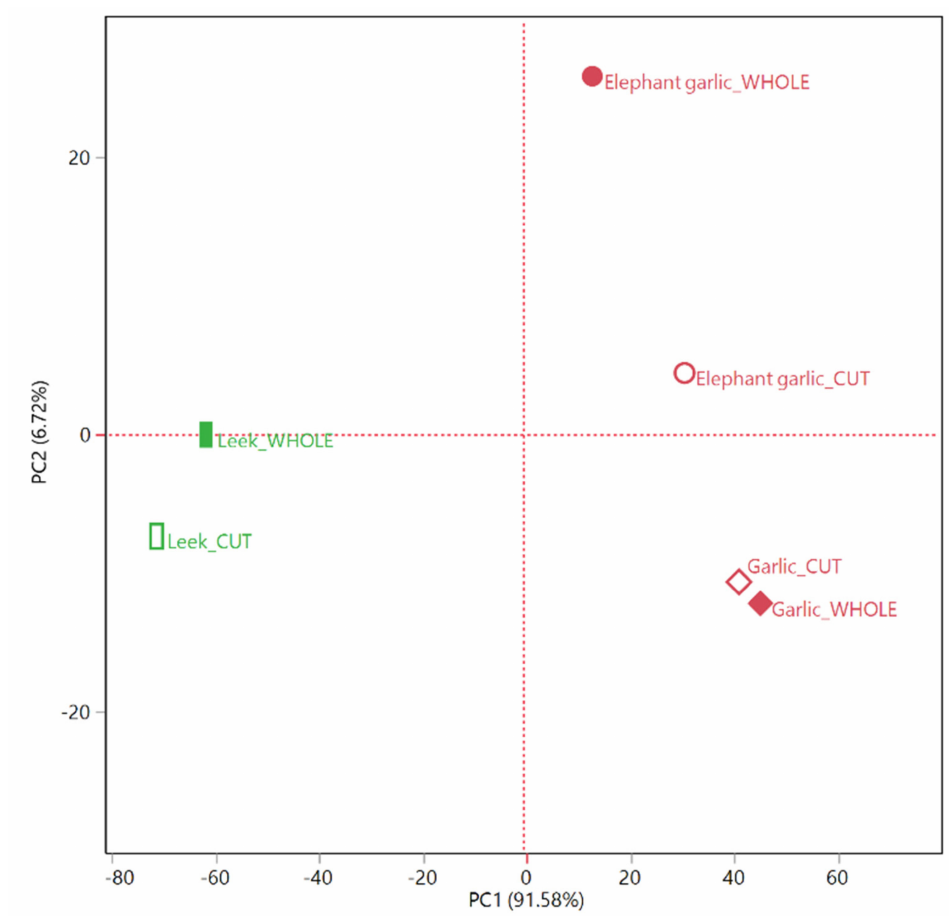
Figure 2. Score plot of the principal component analysis (PCA) performed on the complete compositions of both whole and cut samples of elephant garlic ( Allium ampeloprasum var. holmense (Mill.) Asch. et Graebn), garlic ( A. sativum L.) and leek ( A. ampeloprasum